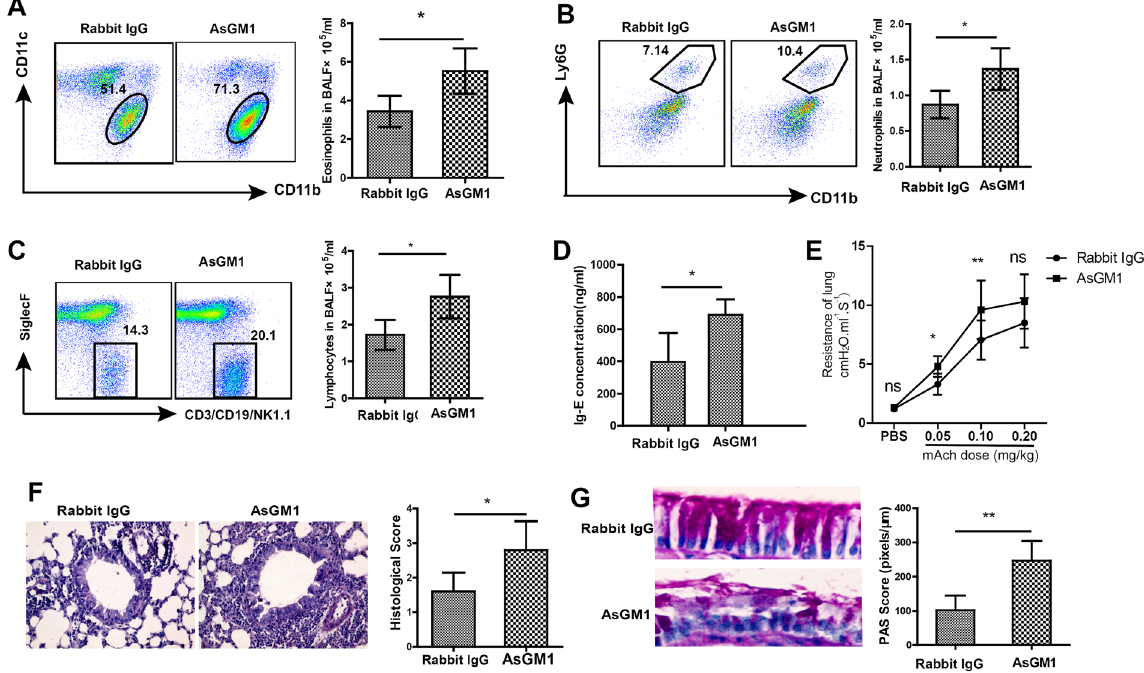
Figure 4. NK cells were essential for IL-28B-suppressed airway inflammation. ( A–C ) Flow cytometry and cell counting assays for abundance and numbers of eosinophils ( A ), neutrophils ( B ) and lymphocytes ( C ) in BALF. ( D ) The effect of AsGM1 treatment on IgE production. ( E ) The effect of AsGM1 treatment on the airway resistance in the mouse lung. ( F ) Histological assessment of lung inflammation in rabbit IgG- and AsGM1- treated asthmatic mice. ( G ) PAS staining for mucus production in lung epithelium of rabbit IgG- and AsGMA1- treated asthmatic mice. * p < 0.05; ** p < 0.01; ns: non-significant ( n = 5 mice per group). Results shown are representative of three independent